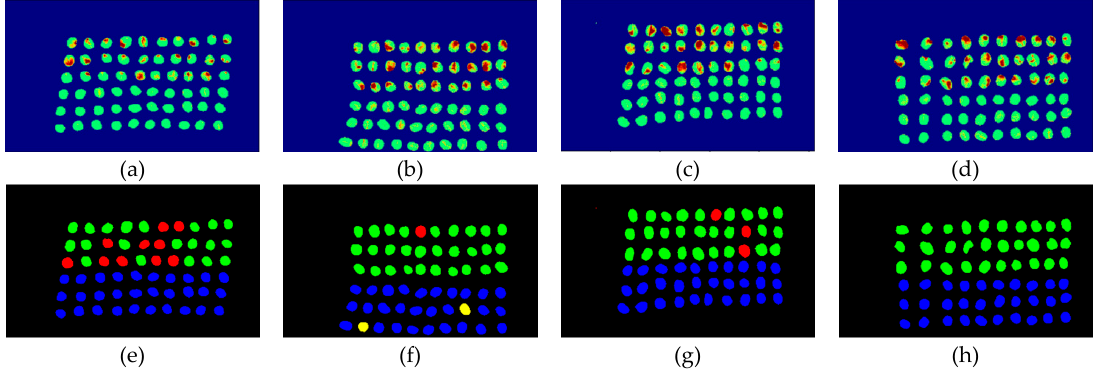
Figure 38. Results of green coffee beans CEM-SVM+CEM_BDM 20 bands. (a-d) SVM classification results, (e-h) final visual images.